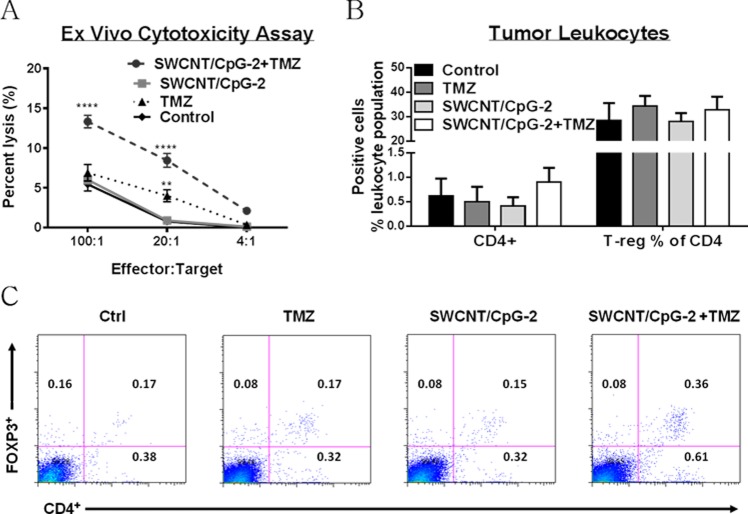
Combination SWCNT/CpG-2 + TMZ enhanced the ex vivo cytotoxicity against K-Luc cells.(A) Splenocytes from K-Luc bearing animals were used in a chromium release assay against K-Luc target cells one week after treatment. 51Cr-Labled K-Luc tumor cells were used as target cells. Cytotoxicity against K-Luc cells was significantly higher in SWCNT/CpG-2 + TMZ treated mice (one-way ANOVA was performed for each effector:target cell ratio. ** P < 0.01, **** P < 0.0001, n = 9). (B) Proportion of intratumoral CD4+ T lymphocytes and regulatory T cells (CD4+FoxP3+) was measured 10 days after treatments. There was no statistically significant change in either cell population (one-way ANOVA, P > 0.05, n = 3 for TMZ group, n = 4 for other groups). (C) Representative flow cytometry data.